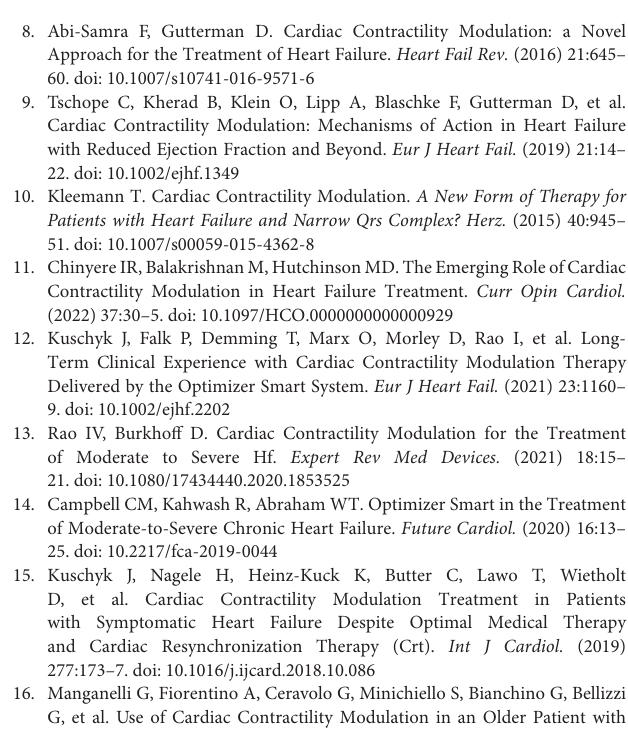
Supplementary Table 1 | Timeline of the case. HF, heart failure; EF, ejection fraction, CRT-D, biventricular ICD; OMT, optimal medical therapy; PAP, pulmonary artery